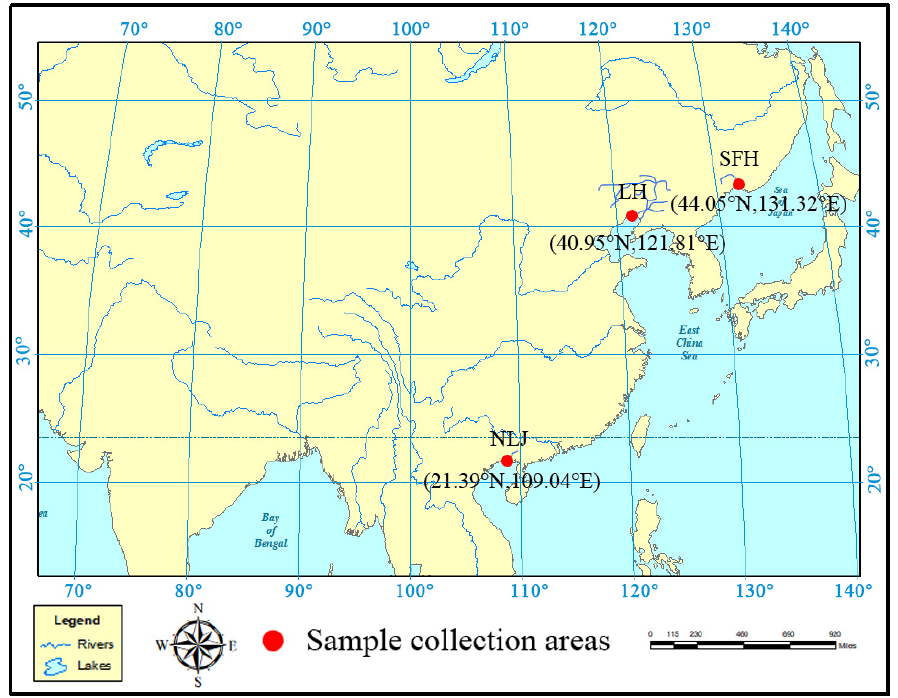
Figure 1. Sampling locations of Eriocheir s. s. populations. The sampling locations, from north to south, were Suifenhe River (SFH), Liaohe River (LH), and Nanliujiang River (NLJ), respectively.